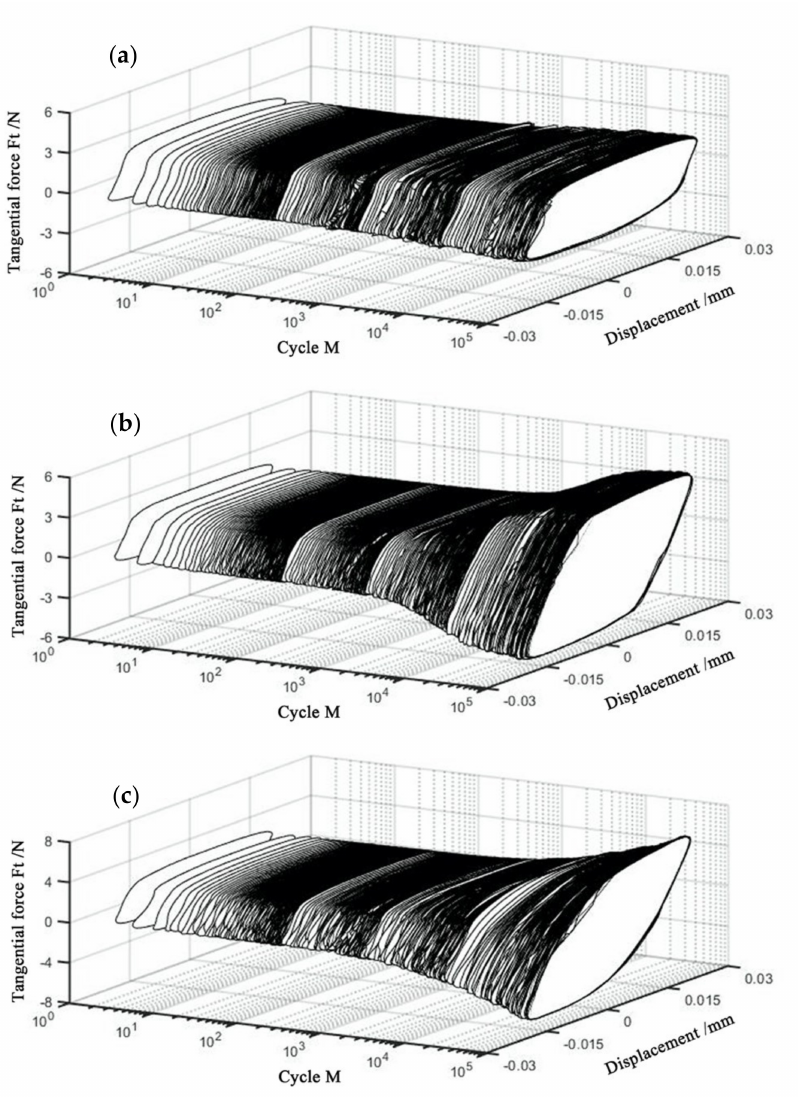
Figure 7. Curves of PVDF thin films with D = ± 20 µ m, ƒ = 15 Hz, and V c = 0 V: ( a ) F n = 15 N, ( b ) F n = 35 N, and ( c ) F n = 50